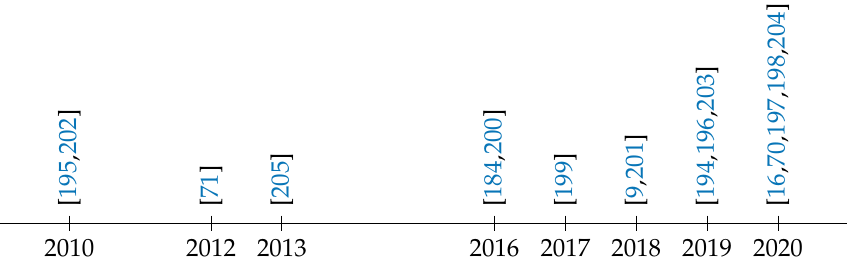
Figure 12. A timeline of different papers within the forum and social network studies theme.